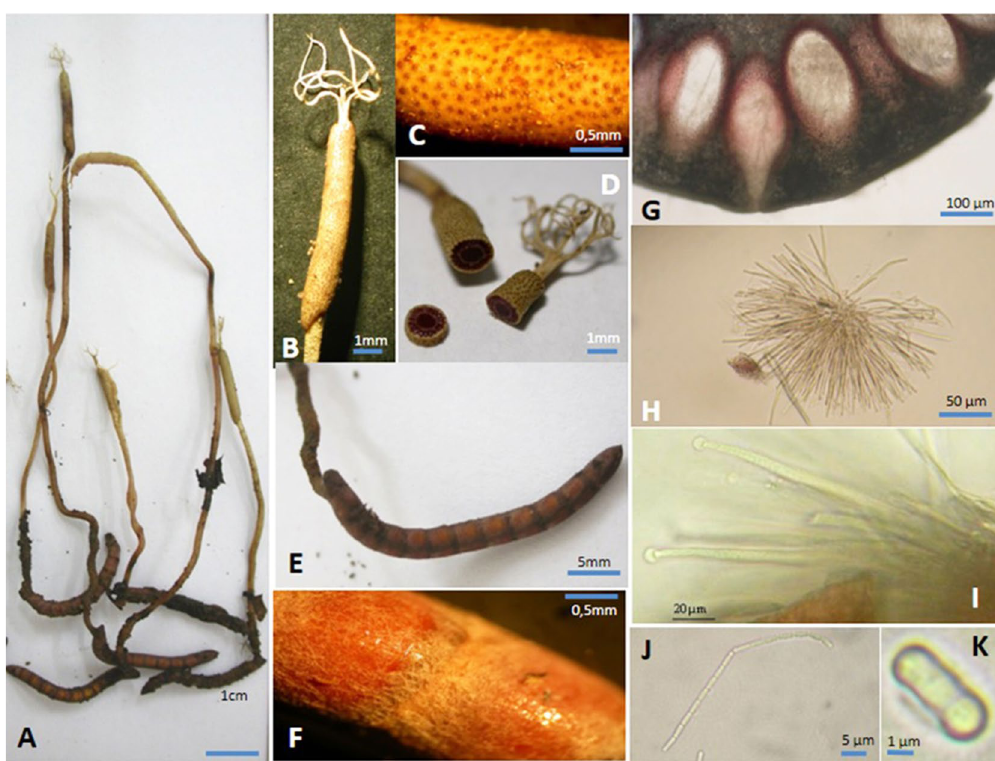
Figure 2. Ophiocordyceps langbianensis . ( A ) Stroma on host; ( B – D ) Fertile part and apical appendix, surface of fertile part with perithecium ostioles, cortex; ( E ) Host; ( F ) Mycelium on the host; ( G ) Perithecia; ( H , I ) Asci with thick cap; ( J , K )